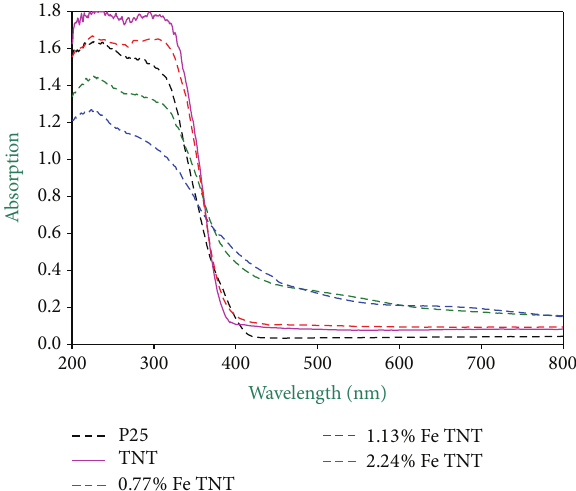
Figure 1: The UV absorption of P25 and Fe-doped TNT.